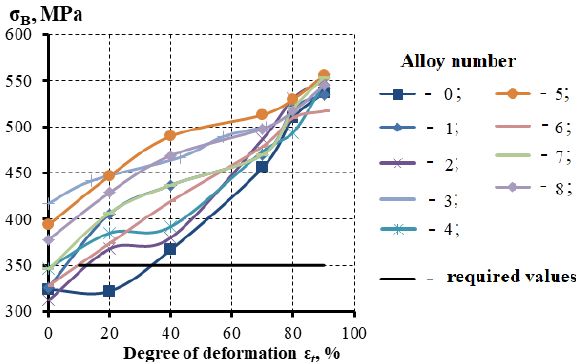
Figure 1: The change in the tensile strength for the investigated alloys